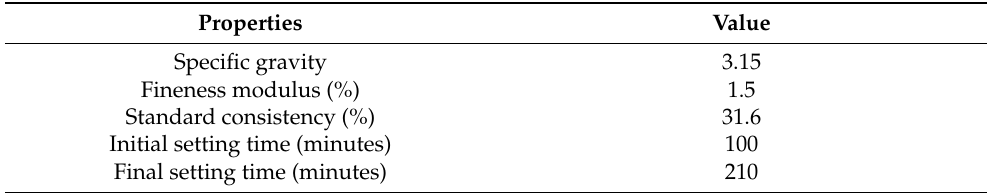
Table 1. Properties of cement.